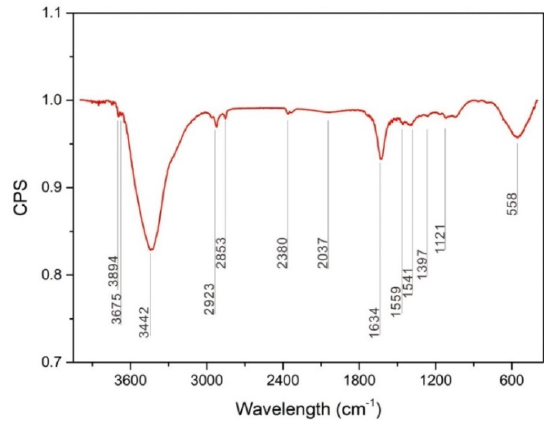
Figure 8. FT-IR spectrum of wear debris produced under conditions of 1 N load after the 1000 cycles.